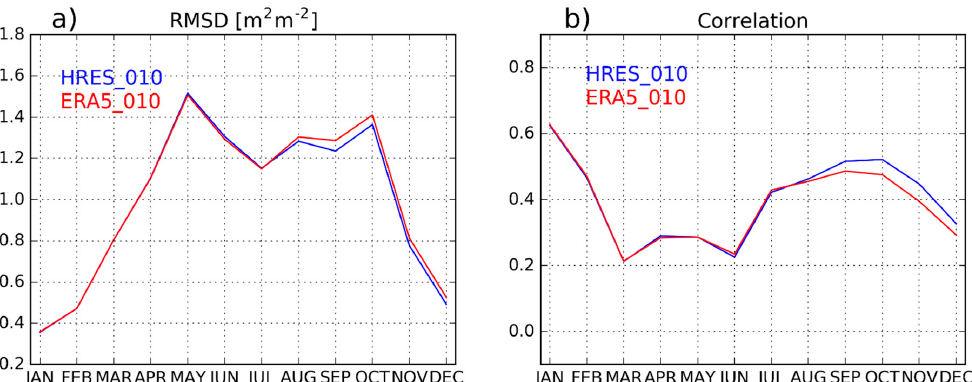
Figure 8. Monthly ( a ) RMSD and ( b ) correlation values between leaf area index (LAI) from the model forced by either HRES_010 or ERA5_010 (ERA5 forcing down-scaled to HRES spatial resolution) and GEOV2 LAI estimates from the Copernicus Global Land Service project for the year 2017.